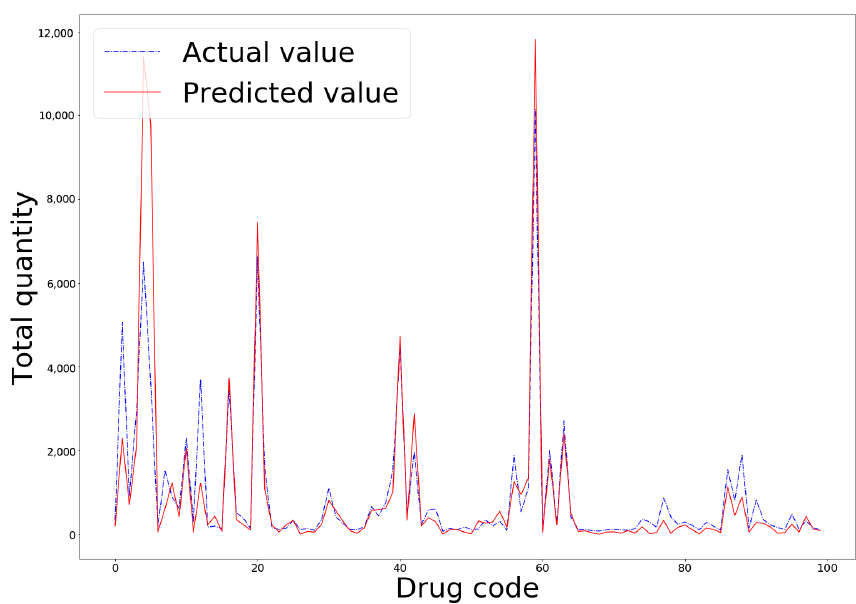
Figure 7. Predicted and actual value comparison for the demand